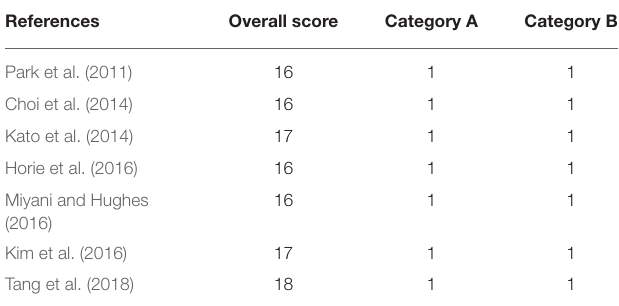
TABLE 3 | General punctuation and categories of the selected